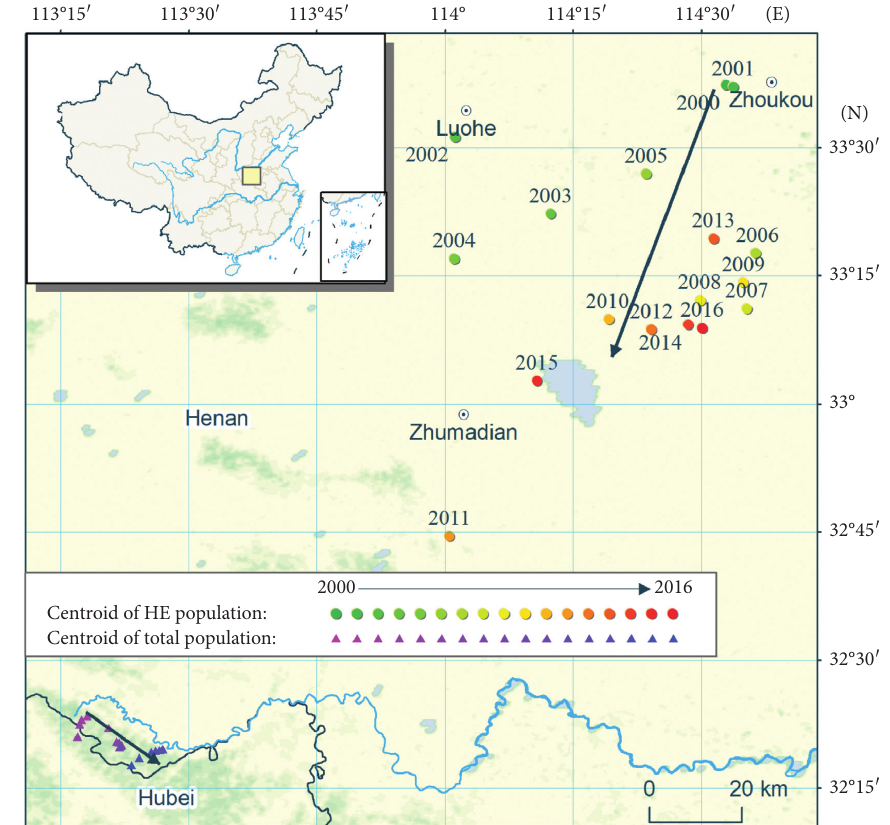
Figure 5: Annual centroids of HEP and total population from 2000 to